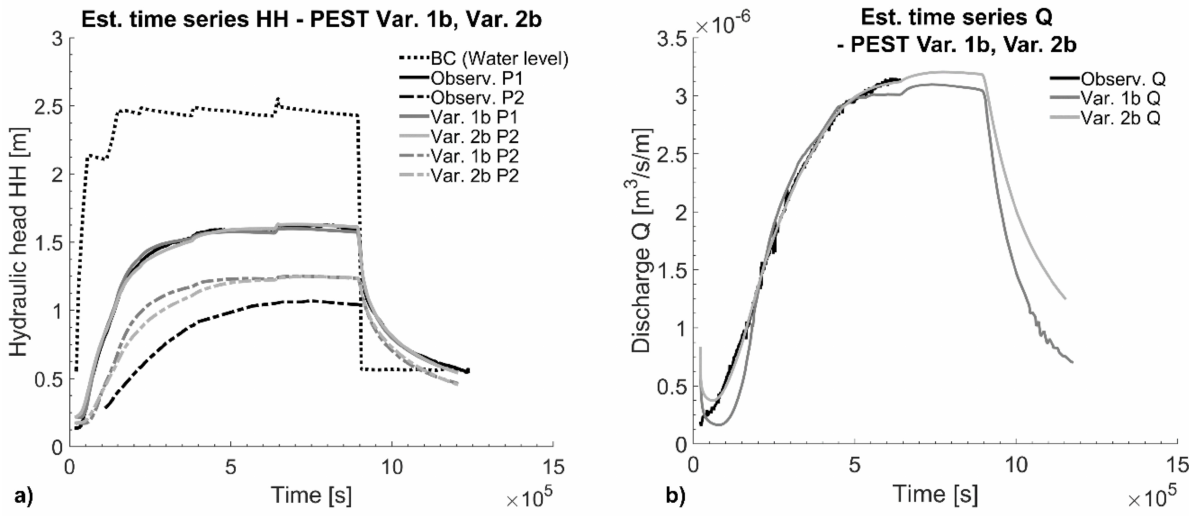
Figure 9. ( a ) PEST approximation of the hydraulic head time series for Var. 1b and 2b; ( b ) PEST approximation of the discharge time series for Var. 1b and